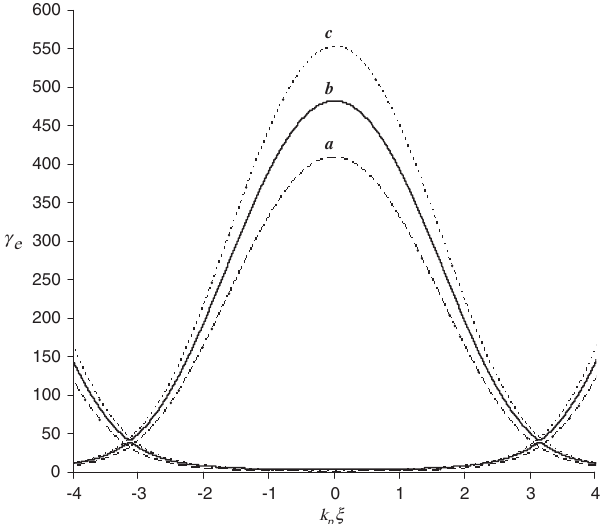
FIG. 8. Separatrix plots for the test electron with (cid:1) ¼ (cid:4) 1 (curve a ), (cid:1) ¼ 0 (curve b ), and (cid:1) ¼ þ 1 (curve c ), with injec- tion energies, respectively, as 17.32, 20.43, and 23.47 MeV, for a 0 ¼ 0 : 3